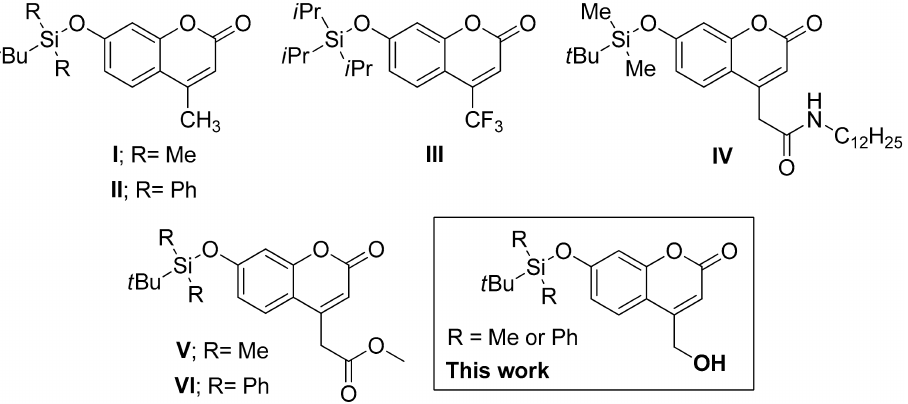
Figure 1. Chemical structures of coumarin-based sensors for fluoride ions reported in previous publications ( I – VI ) and in this